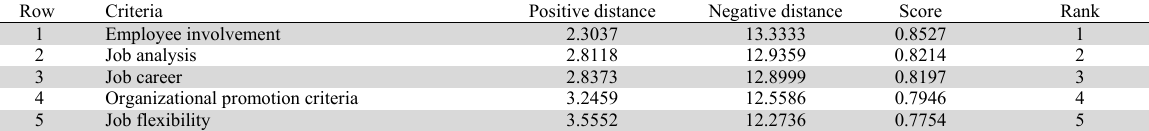
The results of ranking the main Job design sub-criteria Row Criteria